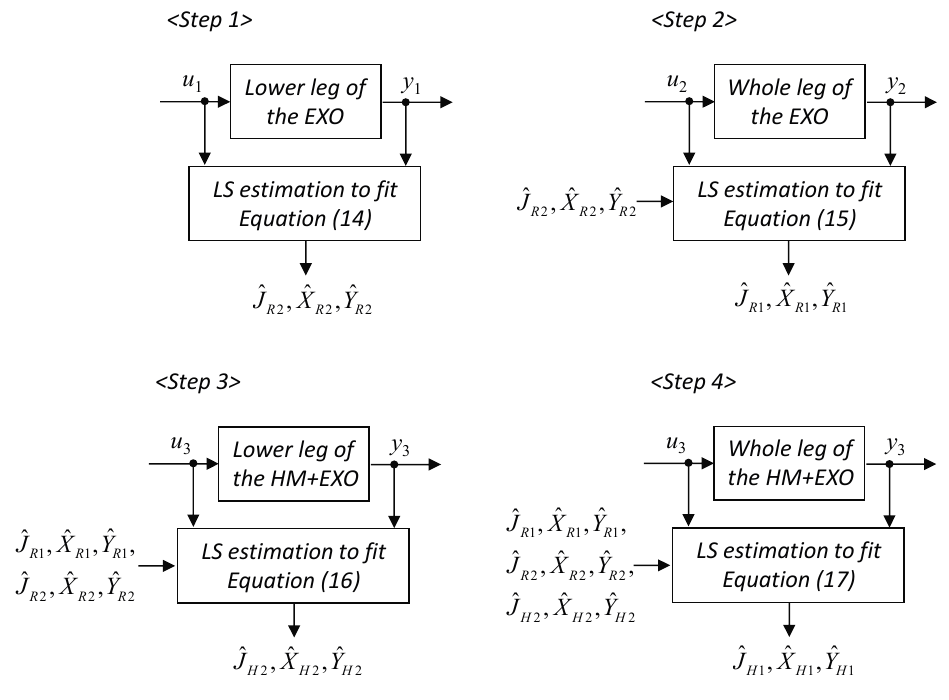
Figure 4. Estimation procedure of the least-squares method. In the figure, HM and EXO represent the human user and the exoskeleton,